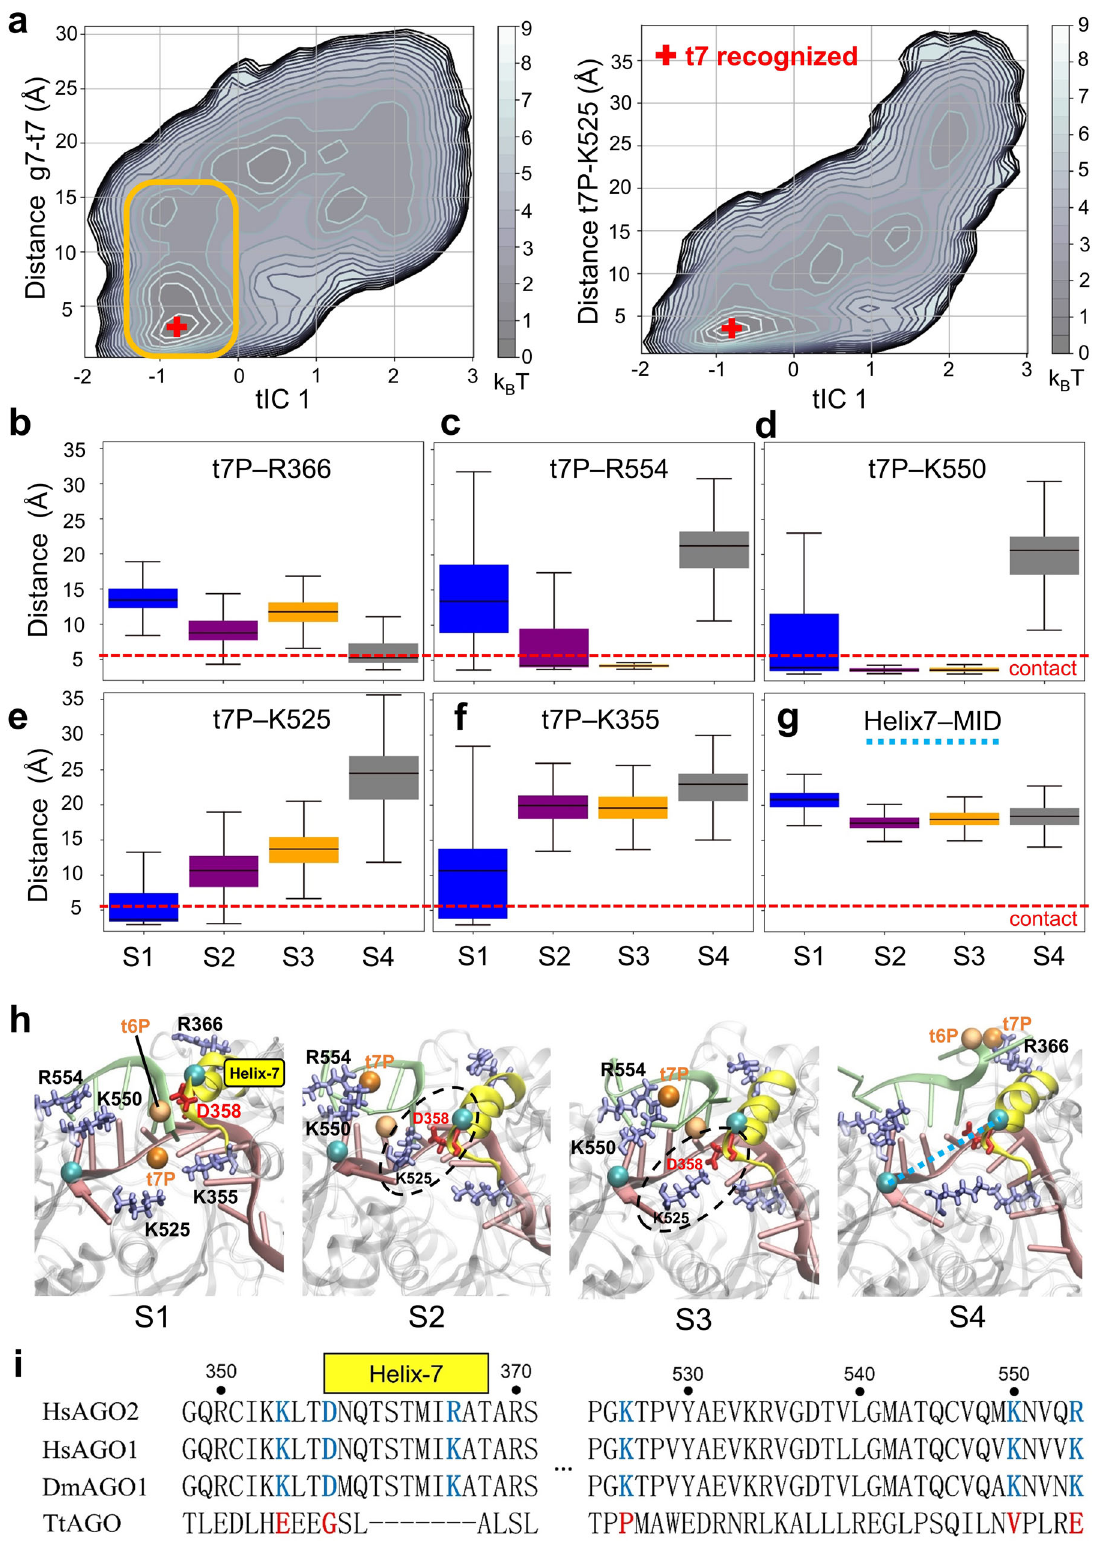
To further verify this observation, we made statistics on all MD conformations within each macrostate over the distances between t7P and all positively charged hAgo2 residues near the RNA loading channel (R366 / R554 / K550 / K525 / K355, Fig. 3b – f, de fi nition in Table S1). Different macrostates have different phosphate-protein interactions. In macrostate S4, t7P is only